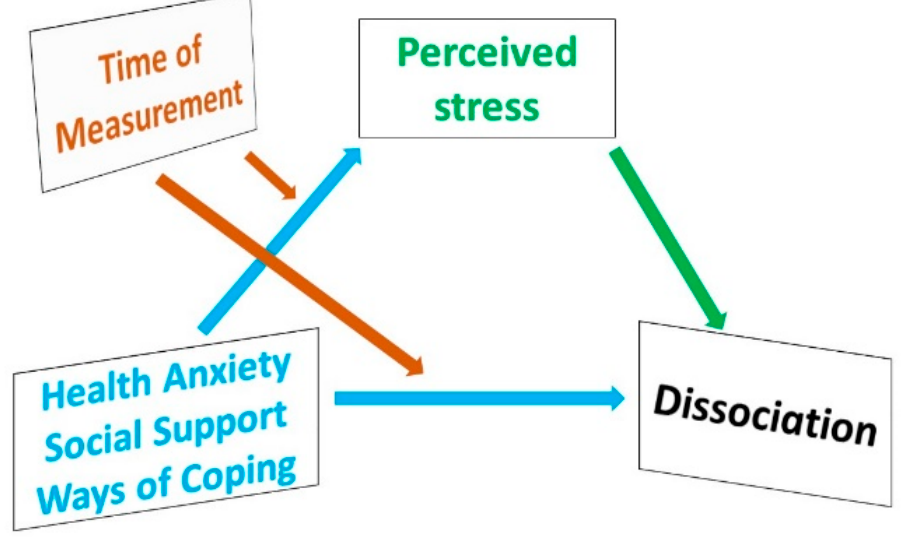
Figure 1. Theoretical model of factors influencing dissociation .